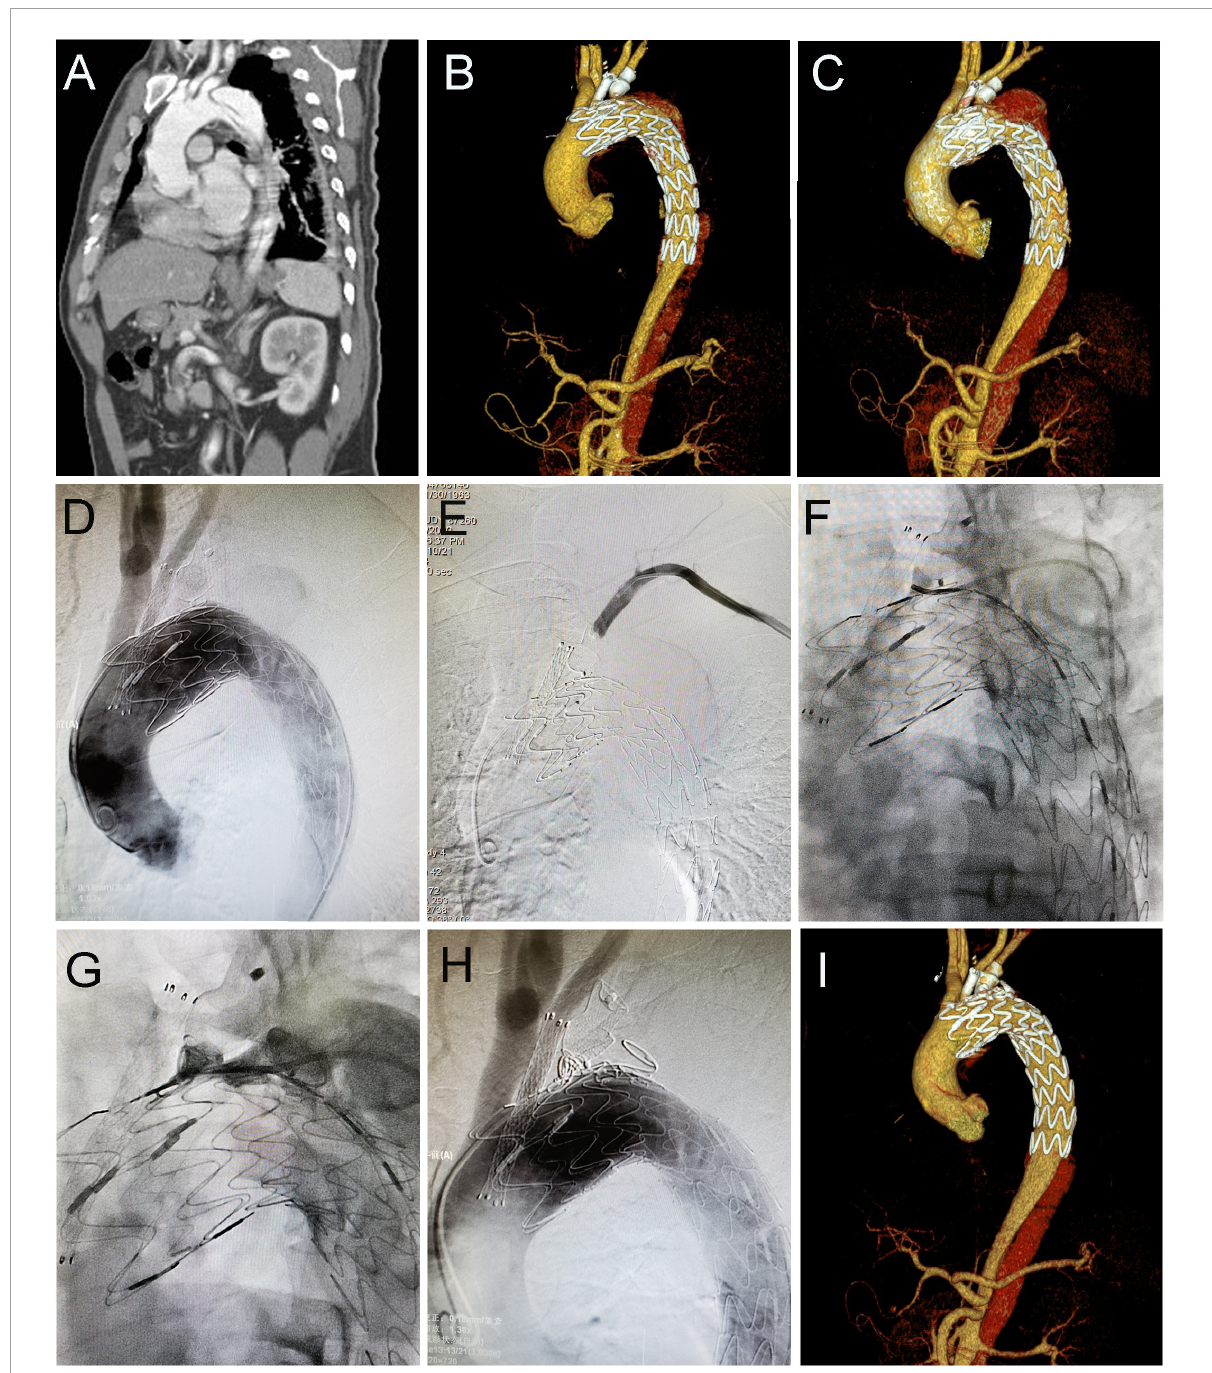
FIGURE2 Coil embolization for type IA endoleak 4 years after cTEVAR. Preoperative computed tomography angiography (CTA) showed aortic dissection involving the arch (A) . The patient underwent cTEVAR with a chimney stent implanted in LCCA and duct occluder implanted in LSA, and postoperative CTA showed a type IA endoleak (B) . The follow-up CTA 4 years later showed the endoleak was significant enlarged (C) . With the catheter located in ascending aorta, an angiogram showed contrast could enter the false lumen (D) . With the catheter located in LSA, the angiogram showed no contrast entering false lumen (E) . With the catheter located in the false lumen, an angiogram showed contrast could enter the aorta (F) . After deployment of coils in the false lumen, an angiogram showed contrast could not enter the aorta (G) . Post-intervention angiogram (H) and CTA (I) showed the endoleak completely disappeared. cTEVAR, TEVAR with chimney; CTA, computed tomography angiography; LCCA, left common carotid artery; LSA, left subclavian artery; aRSA, aberrant right subclavian